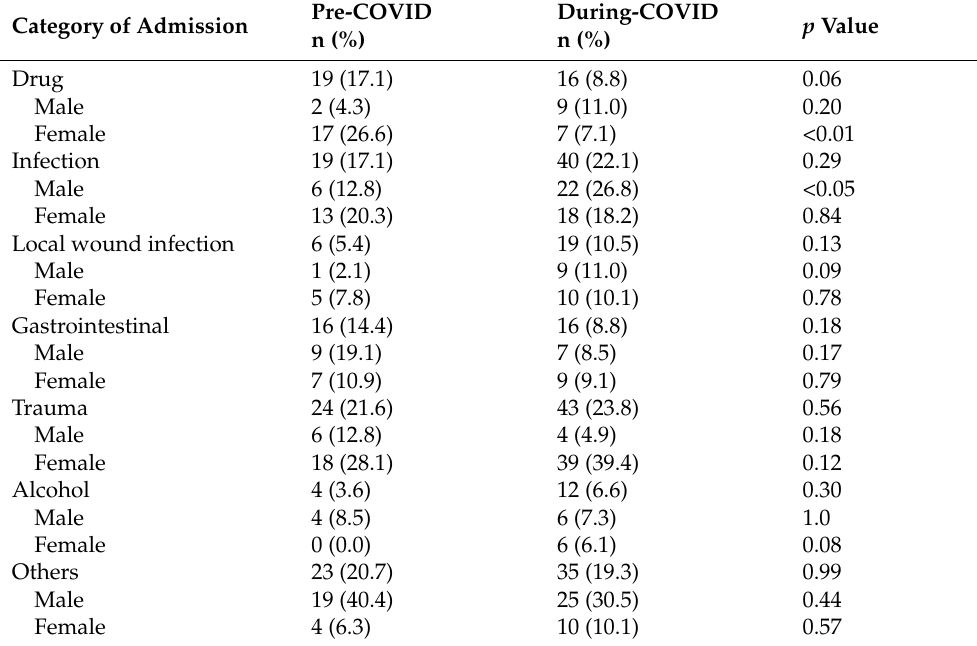
Table A2. Proportional changes in ED admissions among Indigenous patients with SUD before and during COVID-19 pandemic (based on the number of admissions, not the number of patients; some patients had more than one admission).